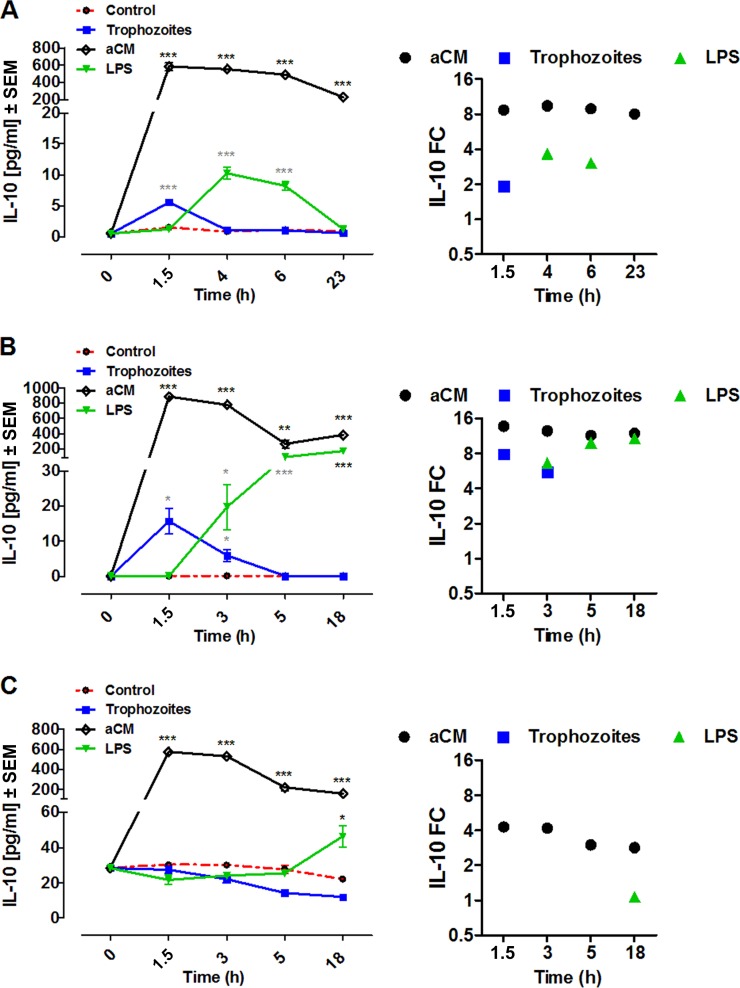
IL-10 production by THP-1 (A), PBMCs (B), and MDMs (C) after coincubation with trophozoites of A. castellanii (trophozoites) or stimulation with aCM. A total of 2 × 105 of either target cells were challenged with either 2 × 104 trophozoites, ratio of 10:1, or with 800 μl of aCM (final dilution of 4:5 in the culture medium). IL-10 concentration in THP-1 experimental supernatants was evaluated at 1.5, 4, 6, and 23 h poststimulation, whereas in both PBMCs and MDMs experimental supernatants it was evaluated at 1.5, 3, 5, and 18 h poststimulation. All three cellular models were stimulated with 10 ng/ml LPS as a positive control, whereas unstimulated cells (control) were considered the negative control. Experiments were performed in triplicate and repeated at least 3 times. Results represent the mean values ± SEM of either n = 5 (THP-1) or n = 3 (PBMCs and MDMs) samples. One-way ANOVA was applied for each time points. Dunnett's multiple-comparison test was performed to evaluate differences between the experimental condition means and the control at each time point. In the graphs, significance between the experimental conditions and the control are indicated as P values of <0.05 (*), <0.005 (**), and <0.0001 (***). Student t test was also applied at each time point to verify the significance of single pairs of means (single experimental condition versus control). In the graphs, significance between the experimental condition and the control, obtained with Student t test, are indicated as P values of <0.05 (*) and <0.0001 (***). On the right, the same results are expressed as fold change (FC) over the unstimulated cells.